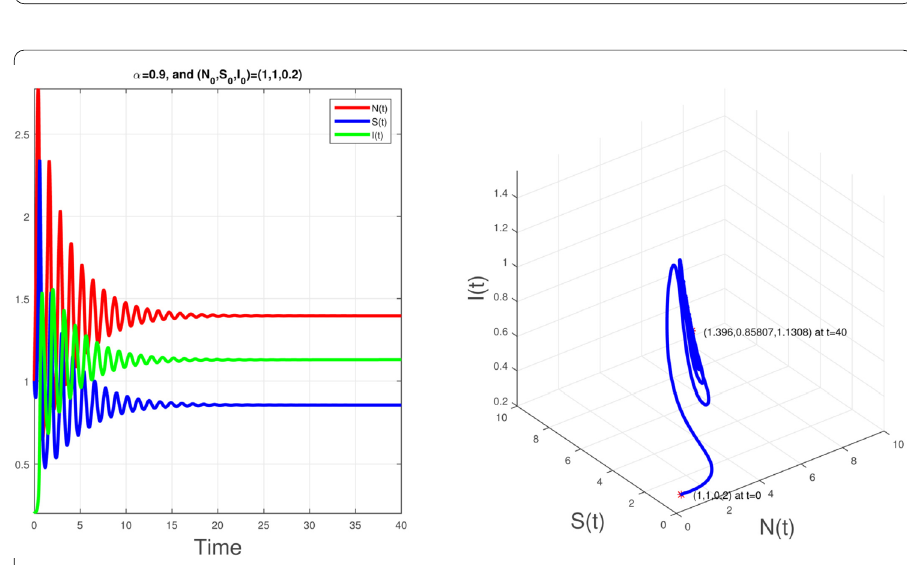
Figure 7 Local stability of the